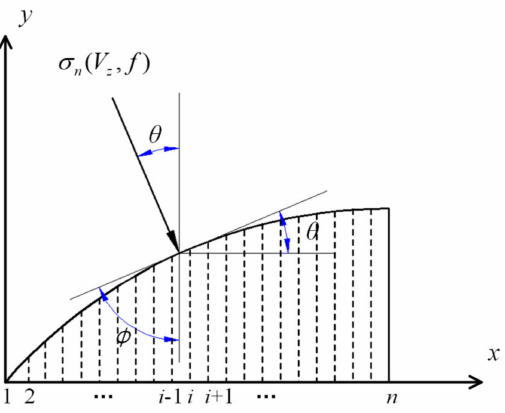
Figure 13. Force analysis on the oval nose of the projectile (source elaborated by